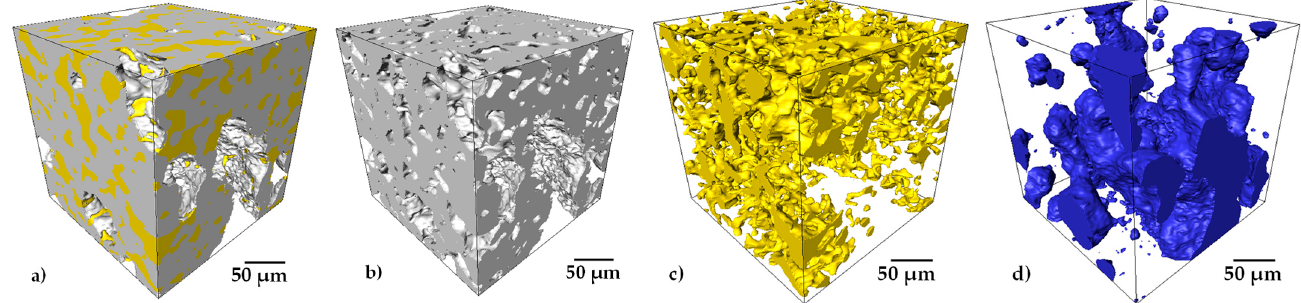
Figure 4. A 3D rendering of a virtually cropped volume showing the interaction of the three phases ( a ) and tridimensional distributions of the individual phases, ( b ) Ti64, ( c ) Ag and ( d ) pores.